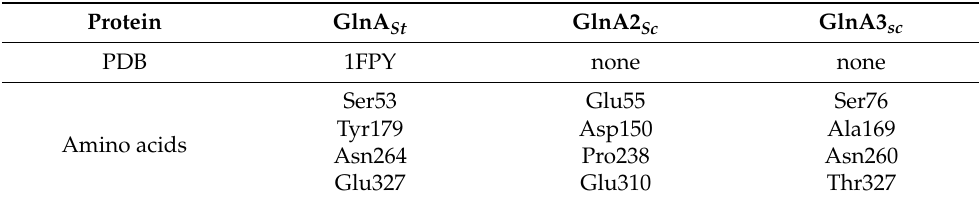
Figure 2. Model structure of GlnA2 from Streptomyces coelicolor . The overall dodecamer structure is based on the GS1 from S. typhimurium (PDB: 1FPY) that was used as a template ( A ). The sub-units A and B are zoomed out and depicted in light red and are superposed with the 1FPY template (yellow) ( B ). The active site is shown with the identified key amino acid substitutions in GlnA2 (red) compared with GS1 from S. typhimurium (dark yellow) ( C ). Table 1. Comparison of amino acid substitutions in the ammonium binding site of the model structure of GlnA2 and GlnA3 from Streptomyces coelicolor with the GlnA from S. typhimurium (PDB: 1FPY).